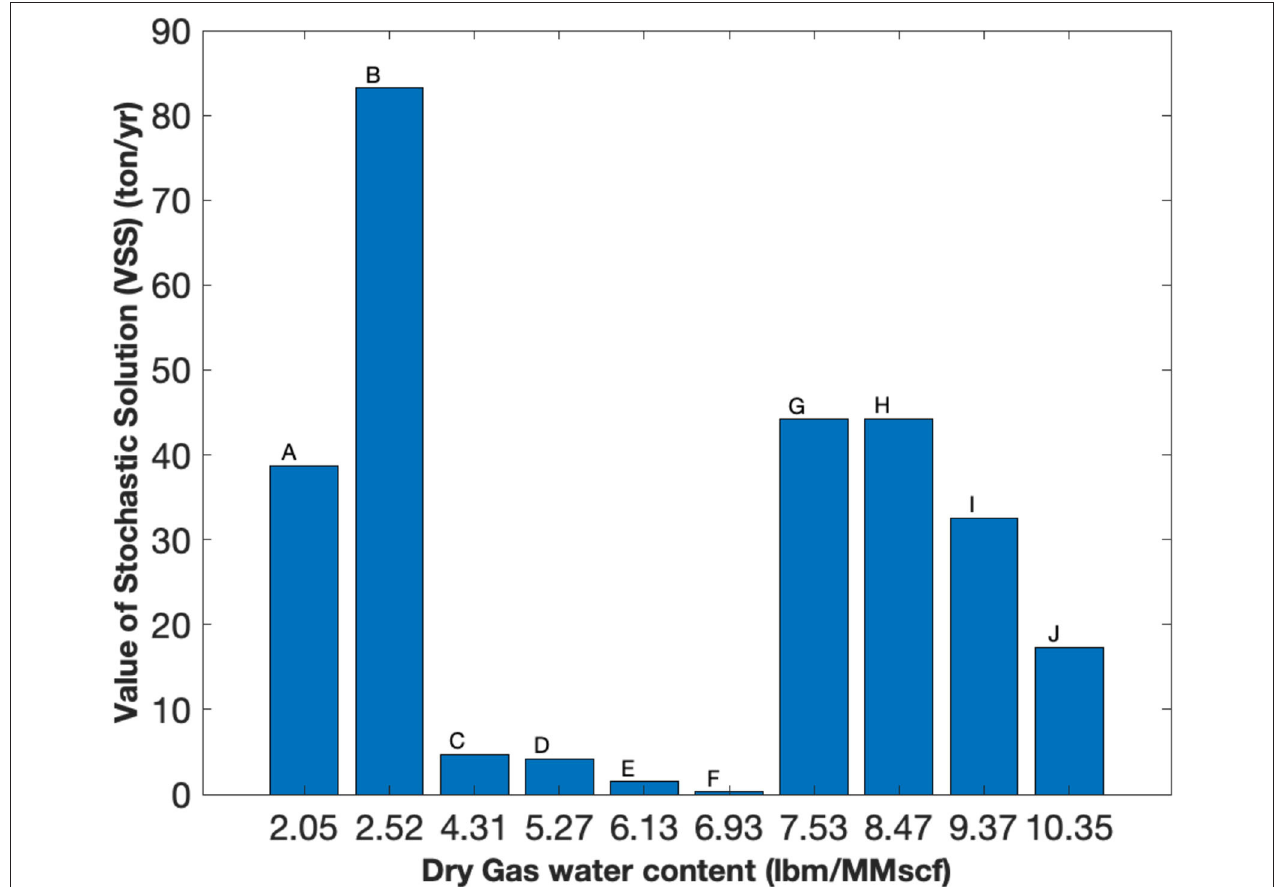
FIGURE 9 | The difference between deterministic and stochastic optimization solution shown by the Value of the Stochastic Solution